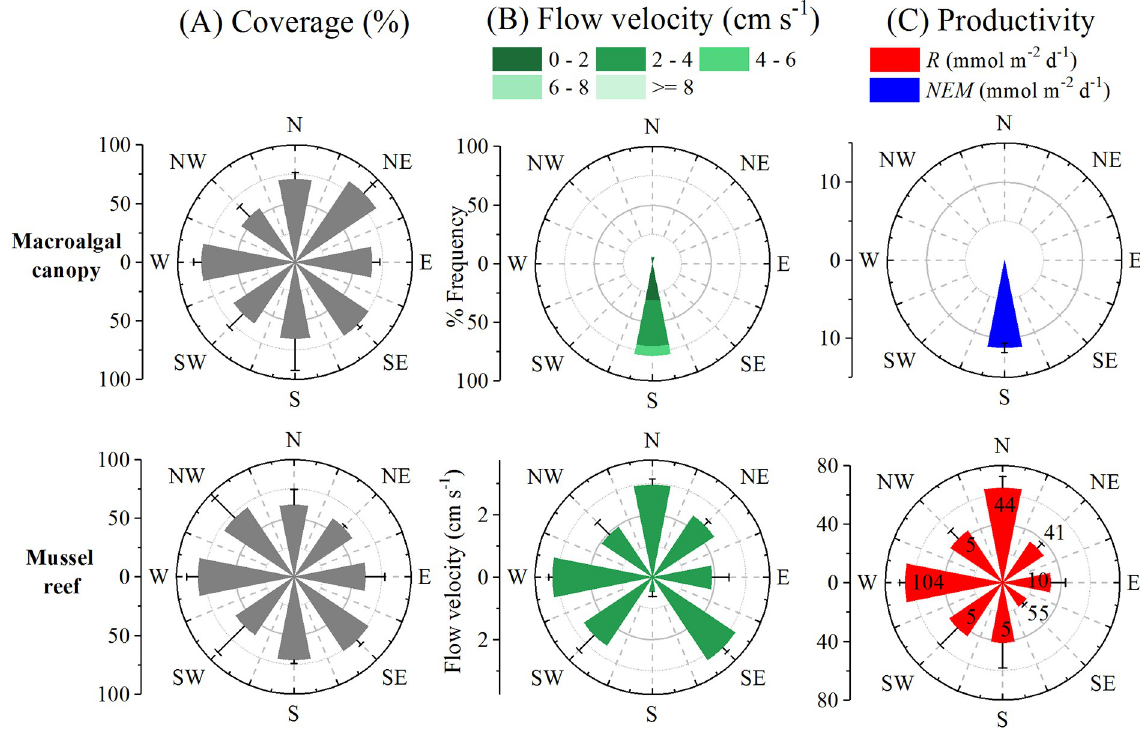
Fig 7. Windrose plots (mean ± SD) for rocky substrates. (A) Coverage (ArcMap, see section 2.7.) of macroalgae and mussels, (B) directional flow velocity distribution, and (C) corresponding seafloor productivity rates, indicating the number of 15 min fluxes.